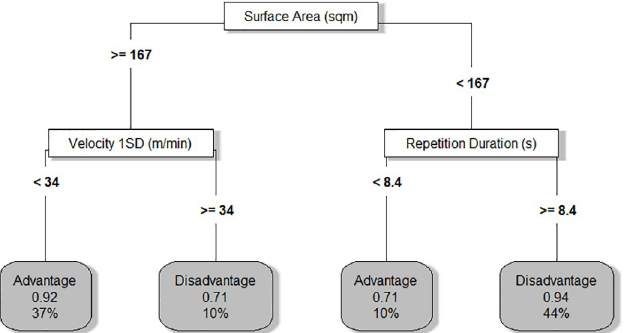
Fig 6. The classification tree used to model the constraint condition (advantage or disadvantage). Terminal nodes are labelled with the predicted constraint condition while the decimals indicate the accuracy of the fitted value and the percentages indicate the frequency of observations.